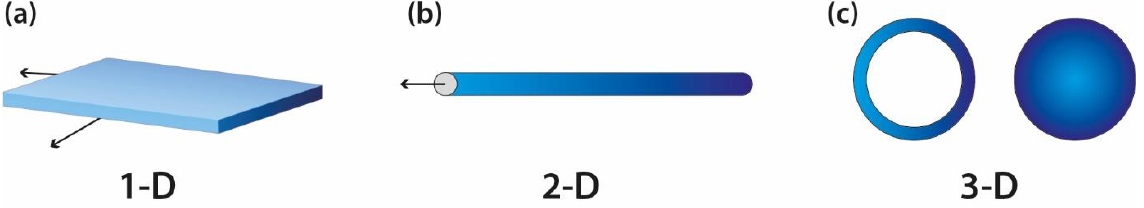
Figure 7. Nanoparticle geometries: ( a ) layered particles (1D), ( b ) acicular or fibrous ones (2D) and ( c ) isodimensional nanoparticles (3D). Adapted from “Block copolymer nanocomposites” [5 7].